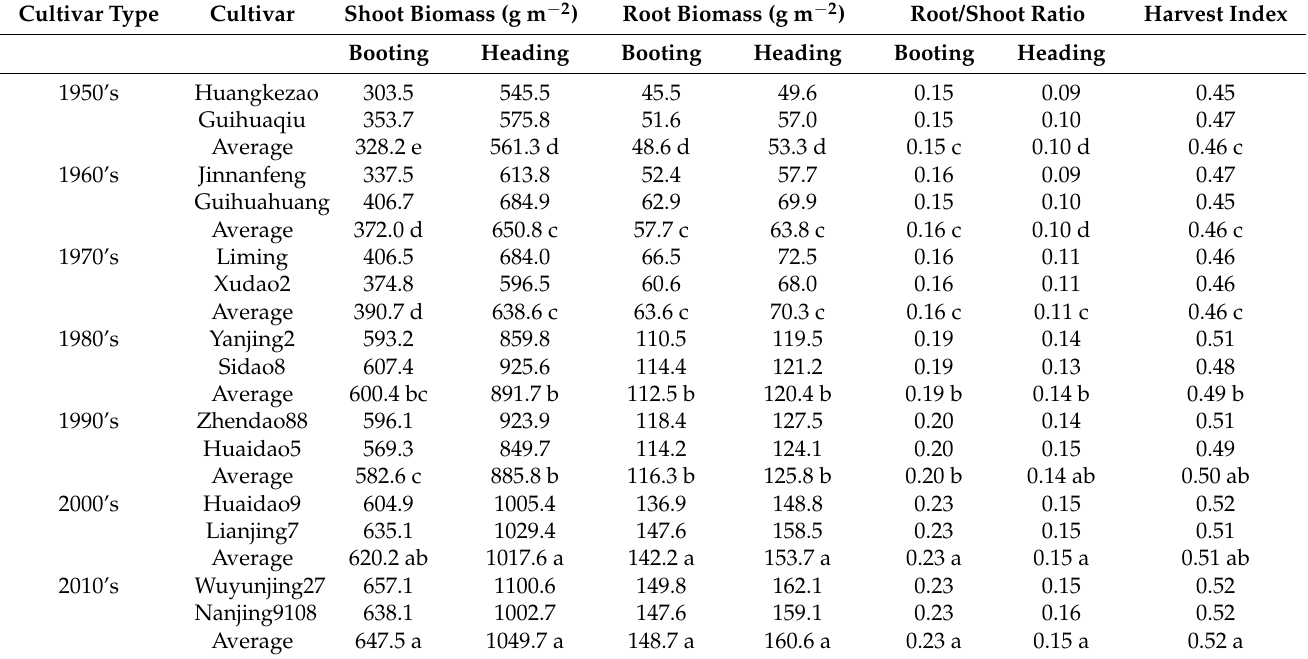
Table 3. Changes in shoot biomass, root biomass, root/shoot ratio and harvest index during japonica rice cultivar renewal.